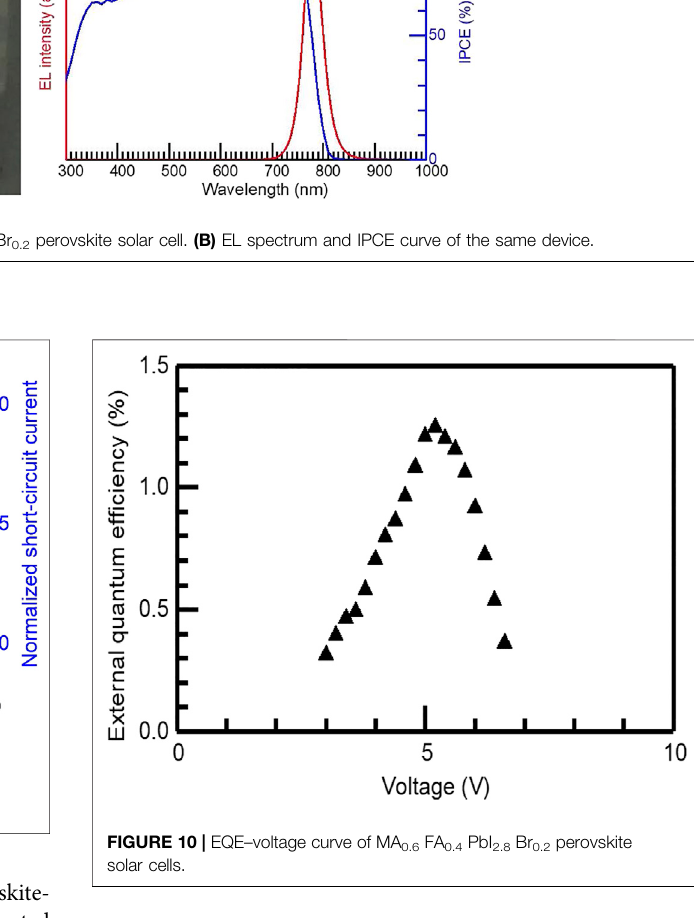
Frontiers in Energy Research |